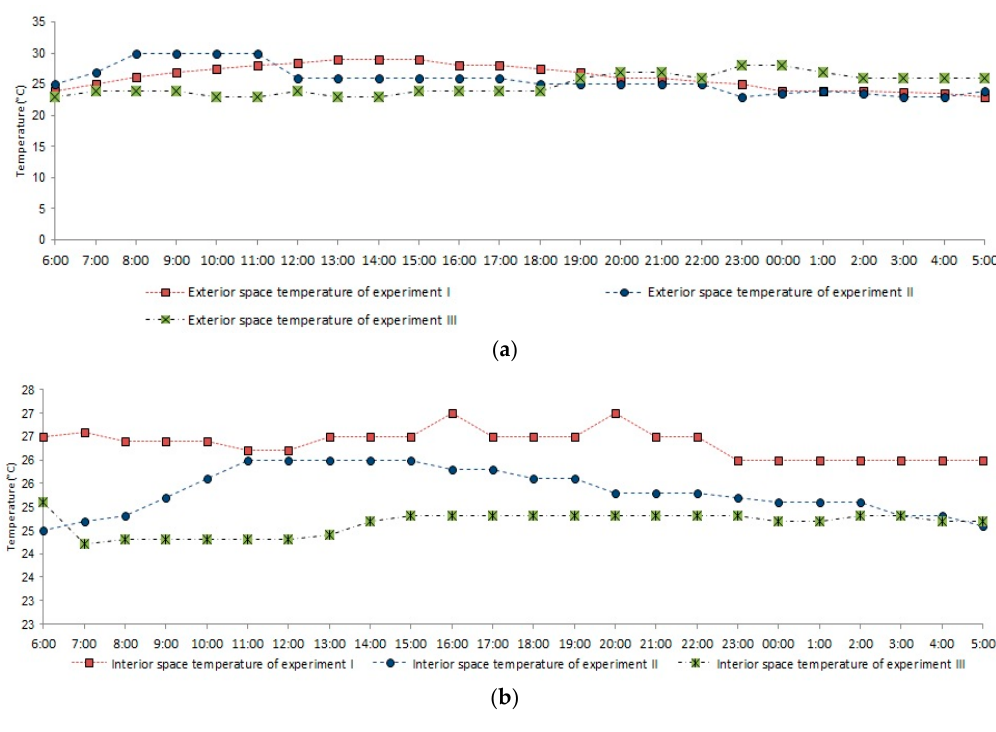
Figure 7. Comparison between: ( a ) exterior space temperature and ( b ) interior space temperature of bare wall and green facade.